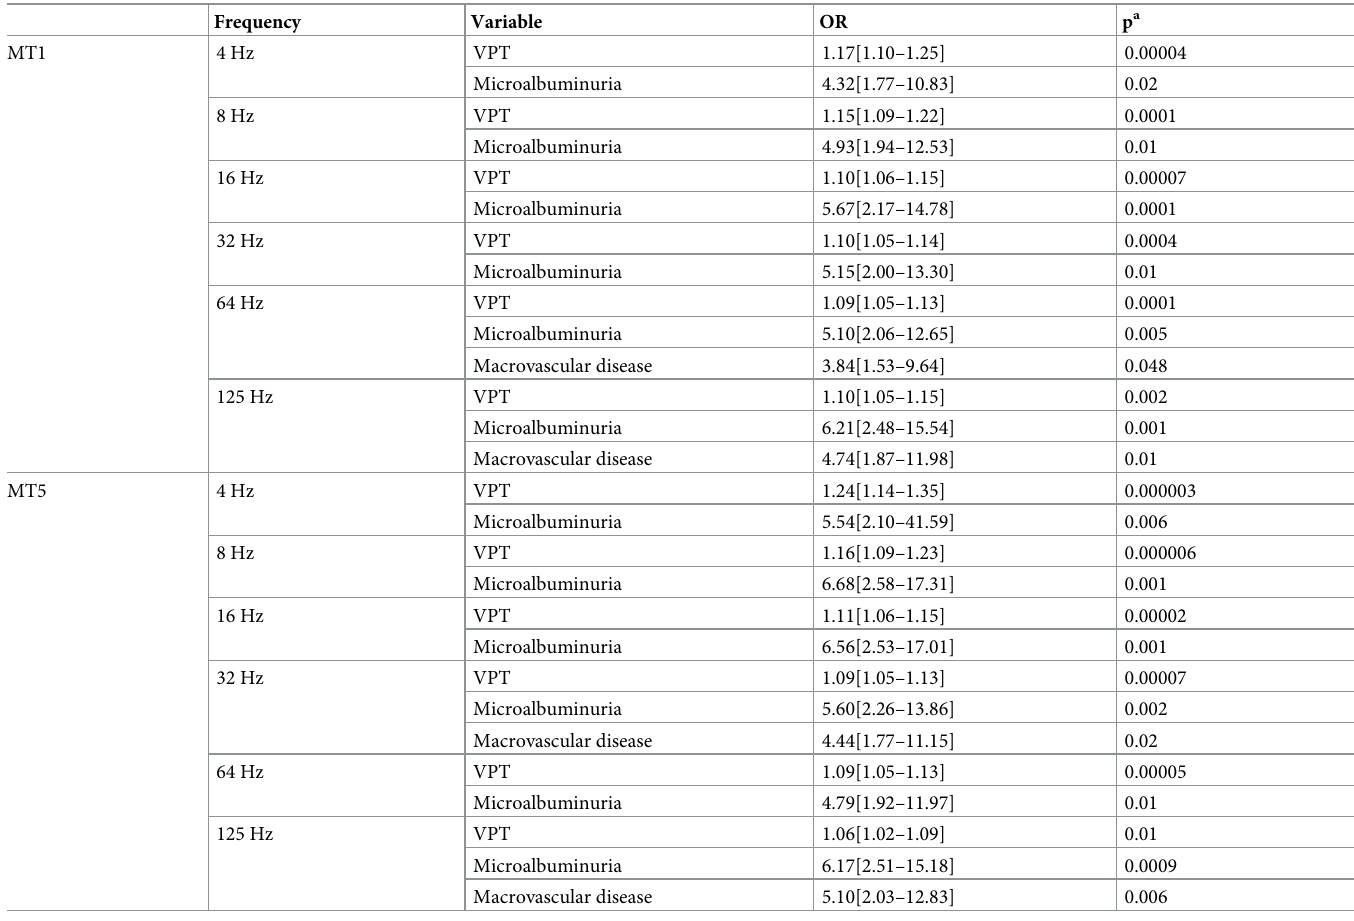
Table 5. Multinomial logistic regression analysis of variables predictive of diabetic foot